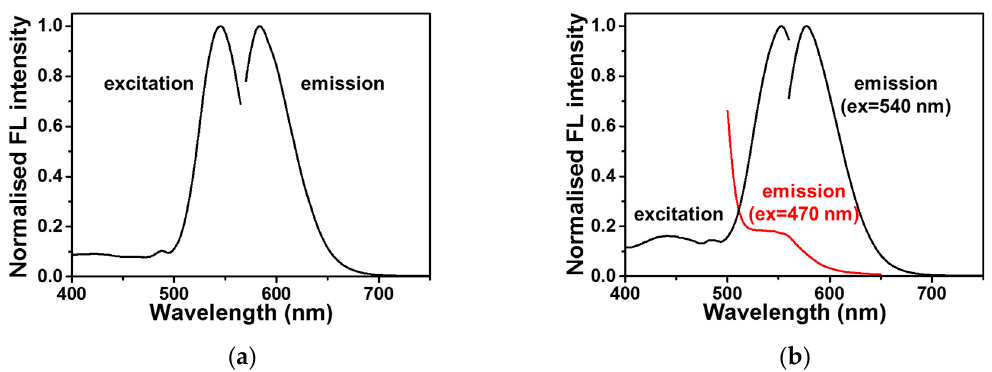
Figure 3. ( a ) The normalised fluorescence (FL) excitation and emission spectra of synthesised C12-templated Ag nanoclusters (NCs) in 3.0 M sodium acetate-acetic acid (NaAc-HAc) (pH 7.0) at 25 ° C; ( b ) the normalised FL excitation and emission spectra of C12-Ag NCs in 3.0 M choline dihydrogen phosphate (dhp)-NaOH (pH 7.0) at 25 ° C.